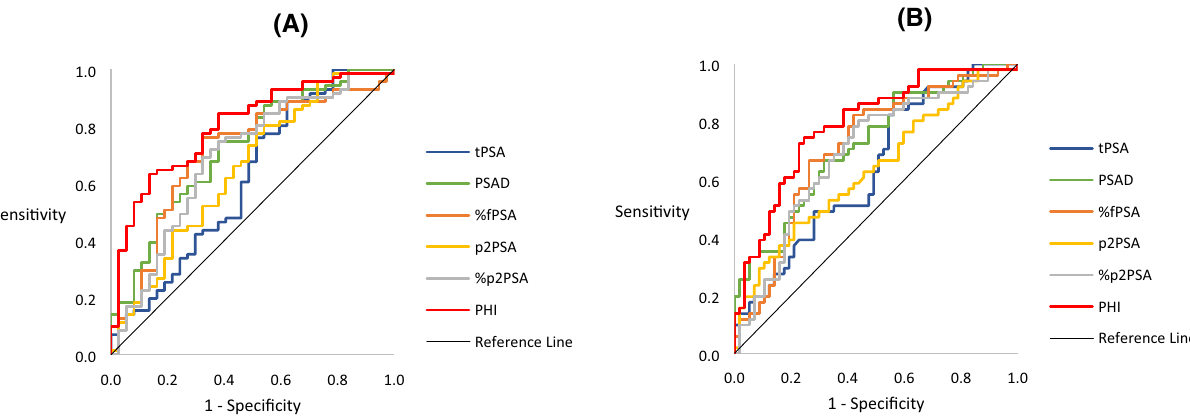
Figure 1. Receiver operating characteristic (ROC) curve analysis for various prostate specific antigen (PSA) derivatives to predict prostate cancer in patients with PI-RADS 4/5. ( A ) Total prostate cancer; ( B ) Clinically significant prostate cancer.